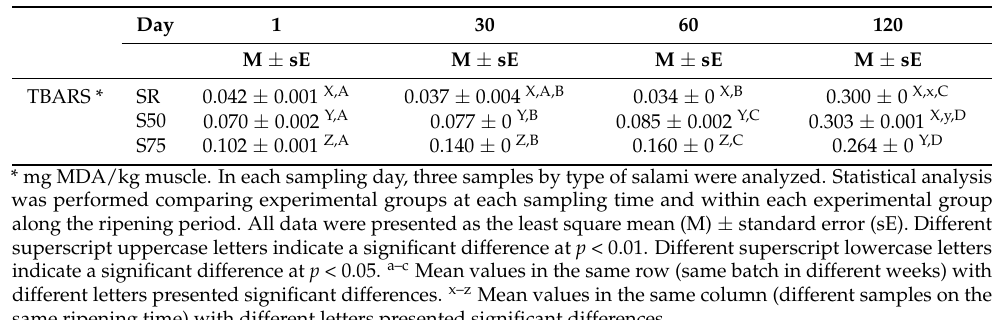
Table 7. Effects of meat species and ripening time on oxidation status of